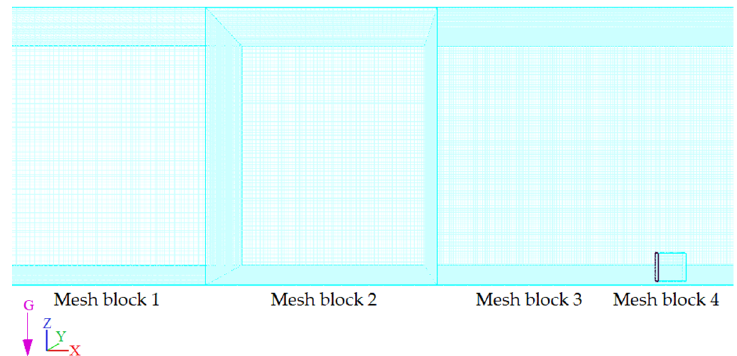
Figure 17. Meshing the channel, using four different grid sizes. Table 9. Grid sizes in each mesh block in the channel.